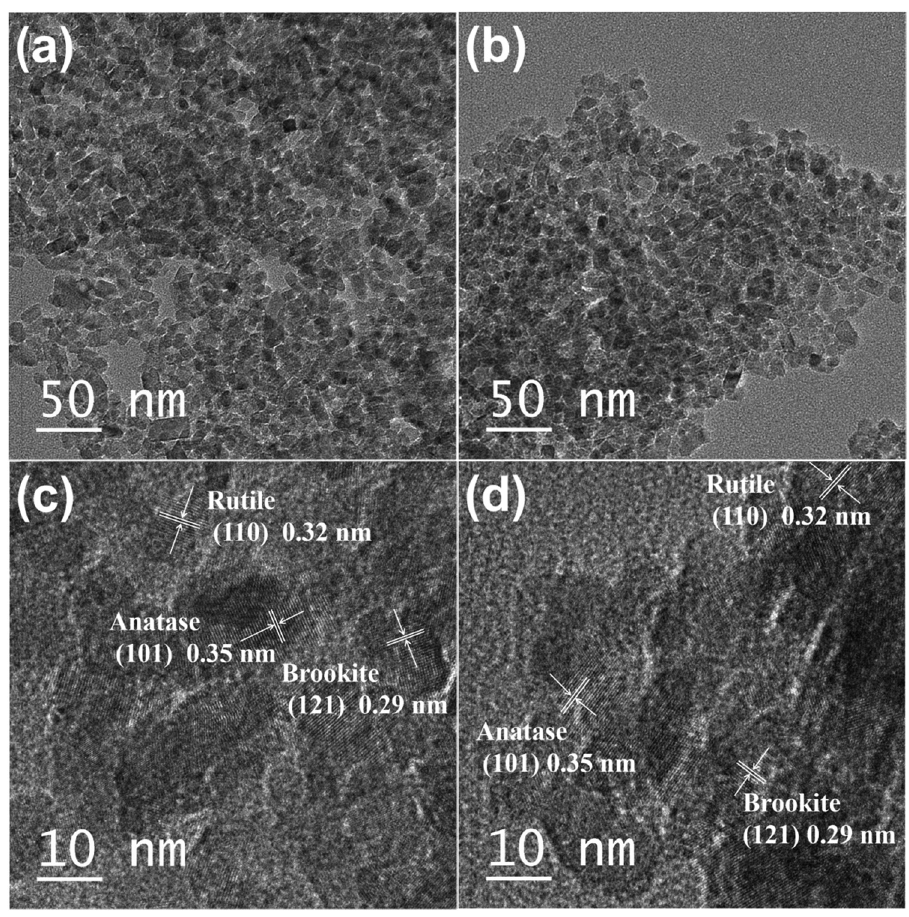
Figure 3: TEM images of ARB ( a ) , Ag@AgCl – ARB ( b ) , HRTEM images of ARB ( c ) , and Ag@AgCl – ARB ( d )